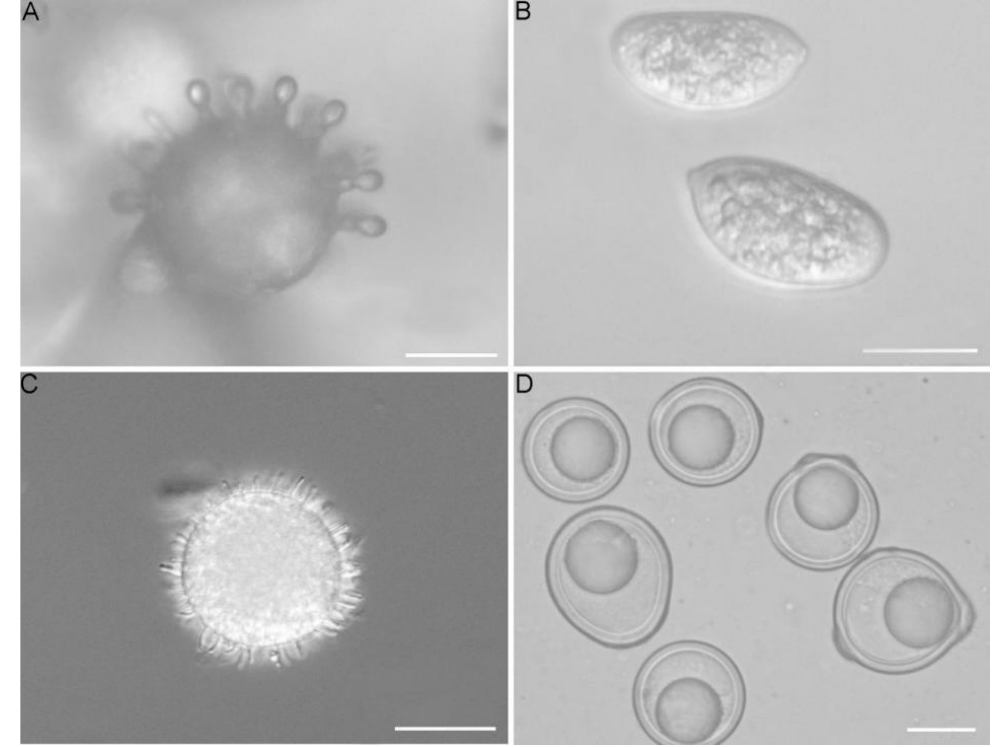
Figure 1. ( A ). Conidiobolus coronatus (microconidia); ( B ). Capillidium macrocapilliconidium (capilliconidia) [13]; ( C ). Conidiobolus coronatus (villose conidia); ( D ). Conidiobolus brefeldianus (zygospores); Scale bars: ( A – D ) = 20 μ m.